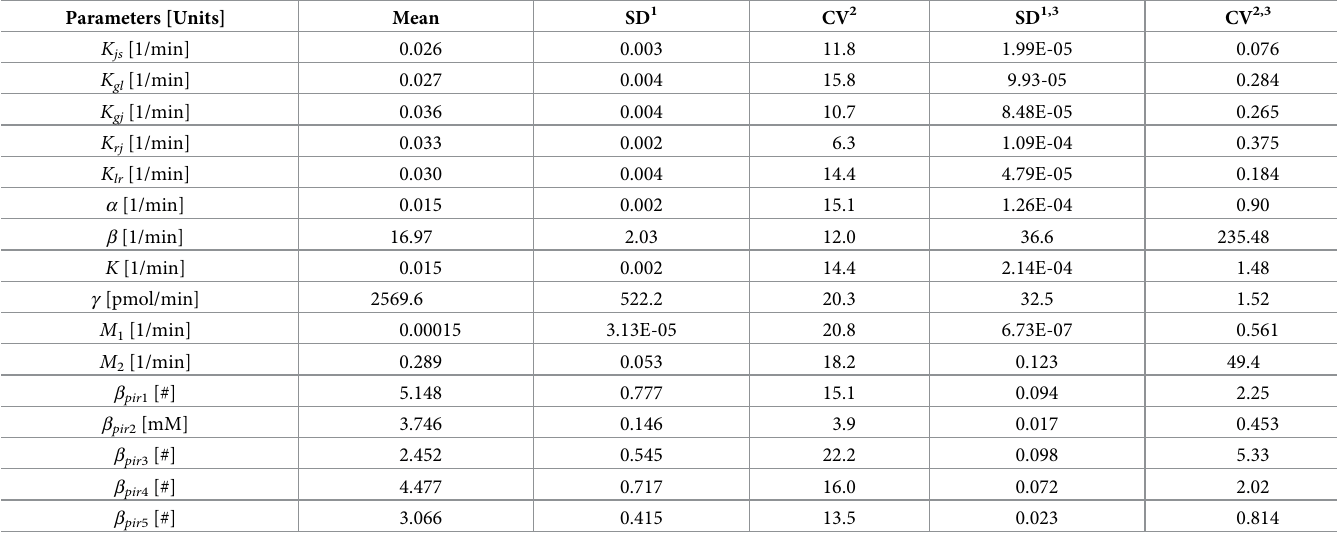
Table 4. STEP 4 results. Summary of the parameter estimate distributions and parameter standard deviations computed by approximation. Parameters